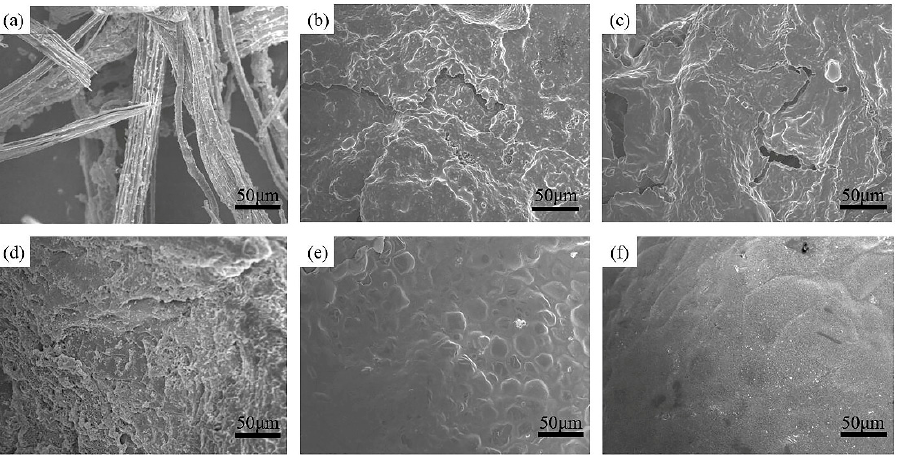
Figure 7. Morphology of the carbon residues after vertical combustion: ( a ) FNFs, ( b ) FNFs-1, ( c ) FNFs-2, ( d ) FNFs-3, ( e ) FNFs-4, and ( f )